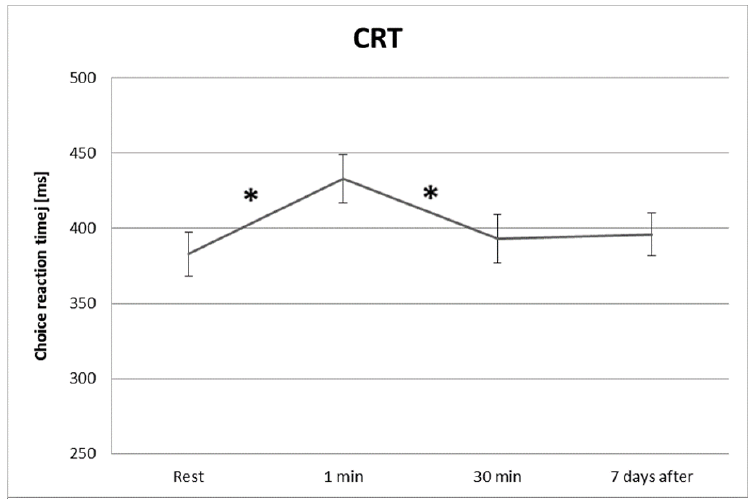
Figure 2. Changes in choice reaction time before and after a marathon exercise (mean ± SE). Statistically significant differences: * ( p < 0.05).